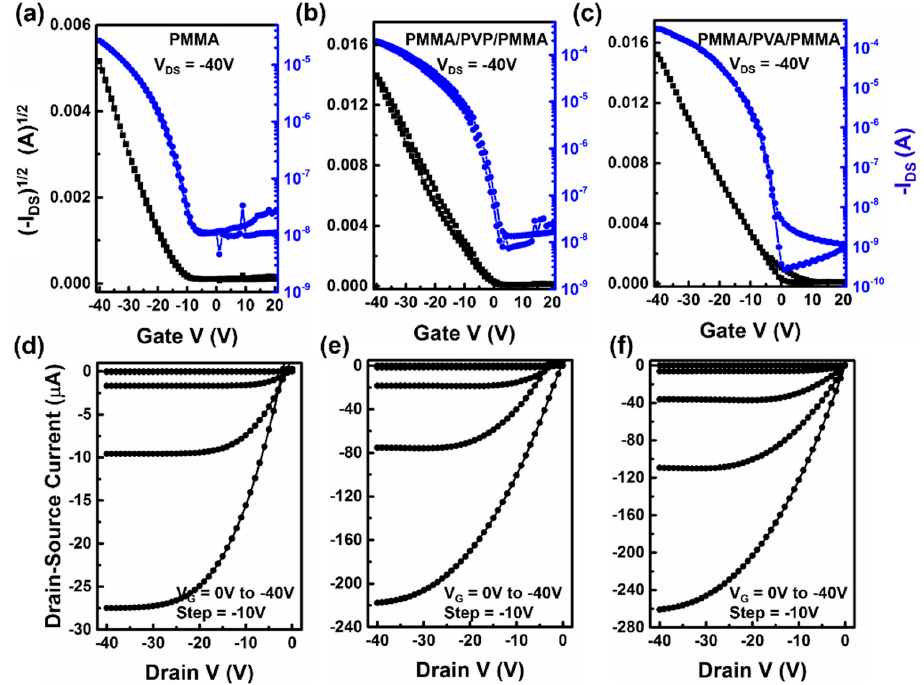
Figure 2. Typical transfer ( V DS = − 40 V) and output ( V G = 0 to − 40 V, with a − 10 V step) characteristics of pentacene-based OFETs with different dielectric structure. ( a , d ) PMMA; ( b , e ) PMMA/PVP/PMMA; ( c , f ) PMMA/PVA/PMMA. Table 1. Characteristics of pentacene-based OFETs with different dielectric structure.